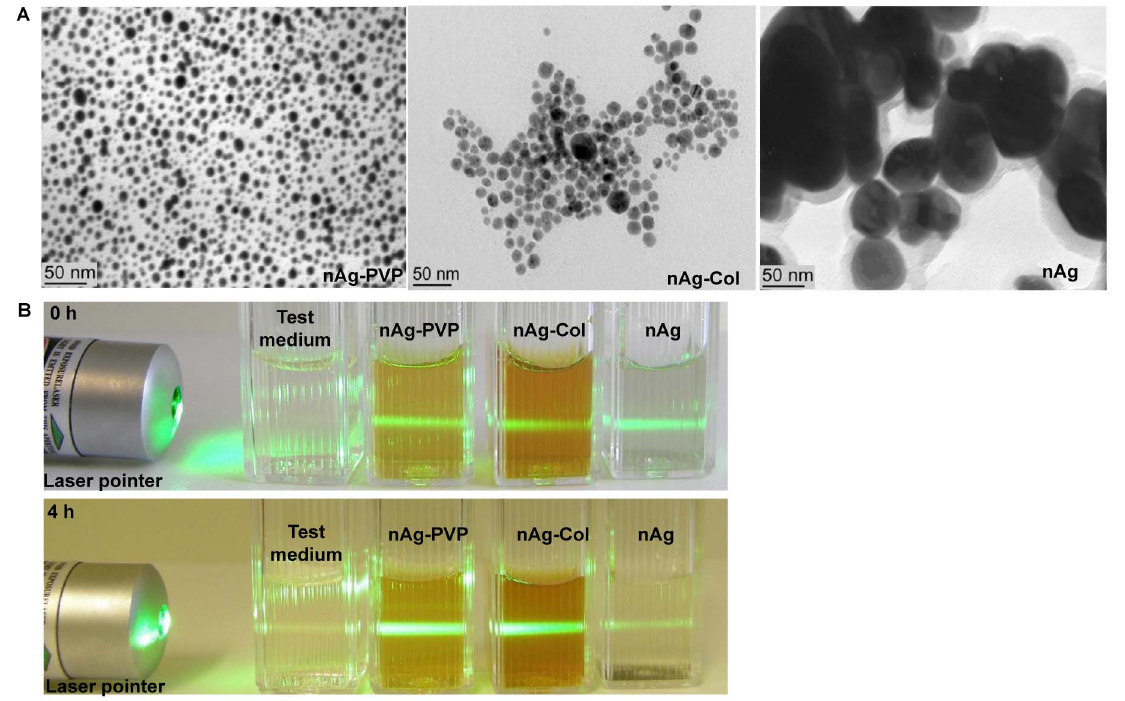
Figure 1. Characterization of silver nanoparticles. A: Transmission electron microscopy images of AgNPs. TEM image of collargol is reprinted from [21] with the permission of Springer. B: Stability of 10 mg/l nanoparticles suspensions in test medium (half-strength NaCl-free LB medium). After 0-h incubation (upper panel), all AgNPs suspensions scattered light upon the illumination by the laser pointer, indicating the presence of particles. After 4-h incubation (lower panel), the light scattering from uncoated nAg was negligible (comparable to that of the test medium with no AgNPs added) and settling of the particles was observed.